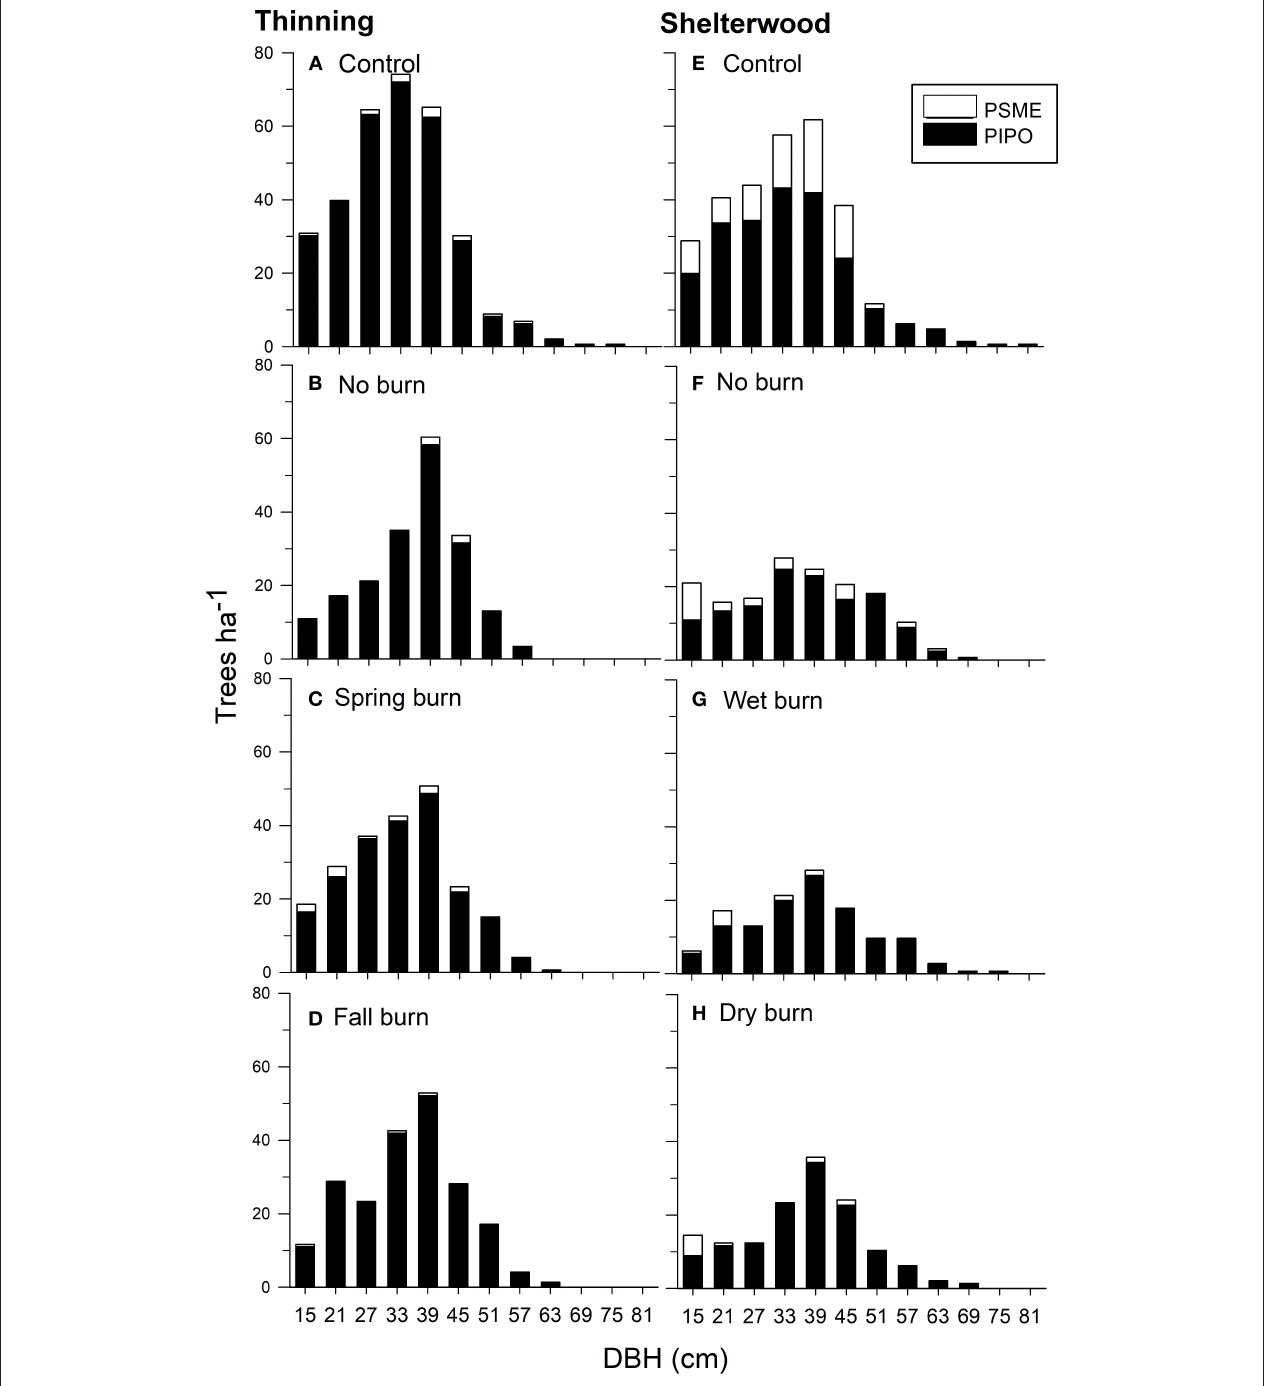
FIGURE 4 | Diameter distributions by treatment and species in the Thinning (A–D) and Retention Shelterwood (E–H) in 2015 (22 years post-treatment). Only Pinus ponderosa (PIPO) and Pseudotsuga menziesii (PSME) are displayed. Other species made up < 1% of the overstory.